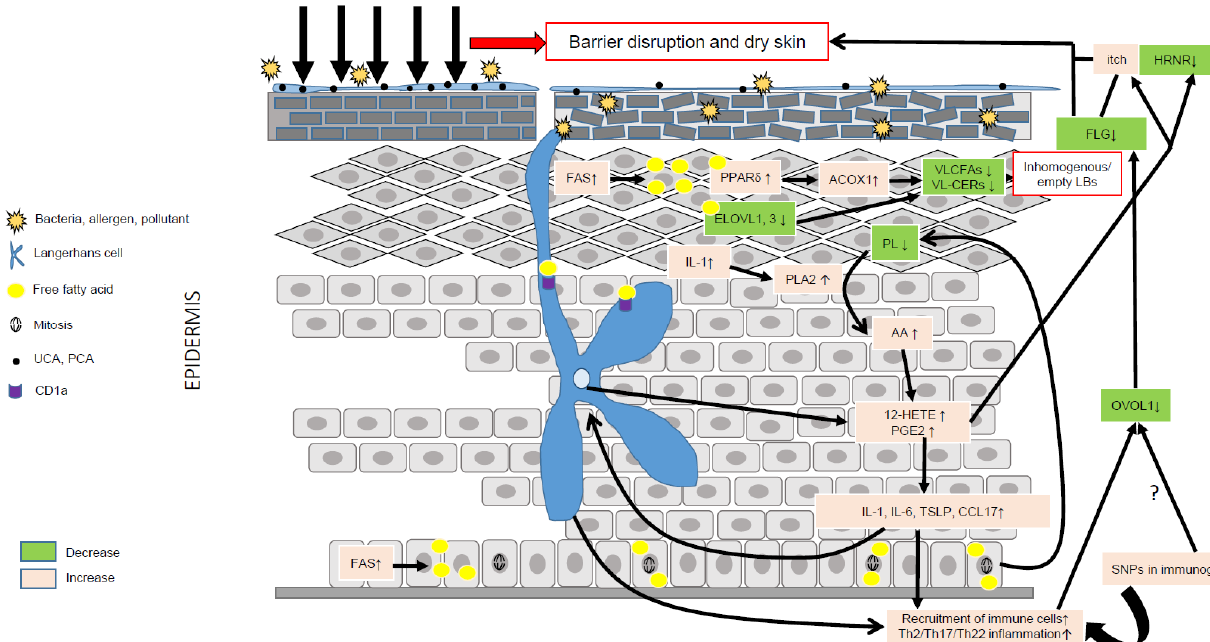
Figure 3. Role of lipid metabolism in AD pathogenesis. Environmental factors such as the microbiota, pollution, climate, allergens and stress can significantly alter the epidermal barrier and lead to dry skin. Compensatory mechanisms aimed at repairing the barrier include production of pro-in- flammatory cytokines such as IL-1, up-regulation of FFA synthesis via FAS, increased synthesis of CHOL via HMGCoA reductase, and of proteins and DNA. IL-1 is a pleiotropic cytokine able to